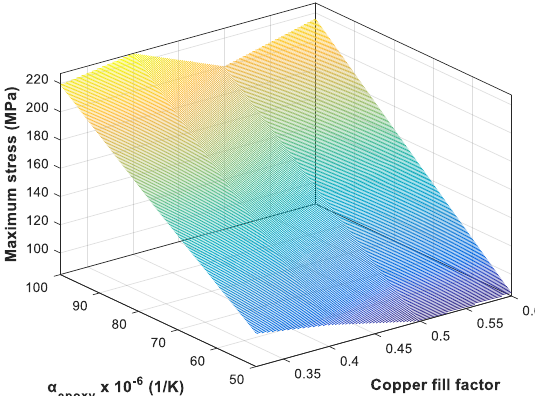
Figure 14. The maximum stress on the copper wire in the middle of the winding, plotted as a function of the copper fill factor and the coefficient of thermal expansion of the epoxy when the temperature distribution is non-uniform.